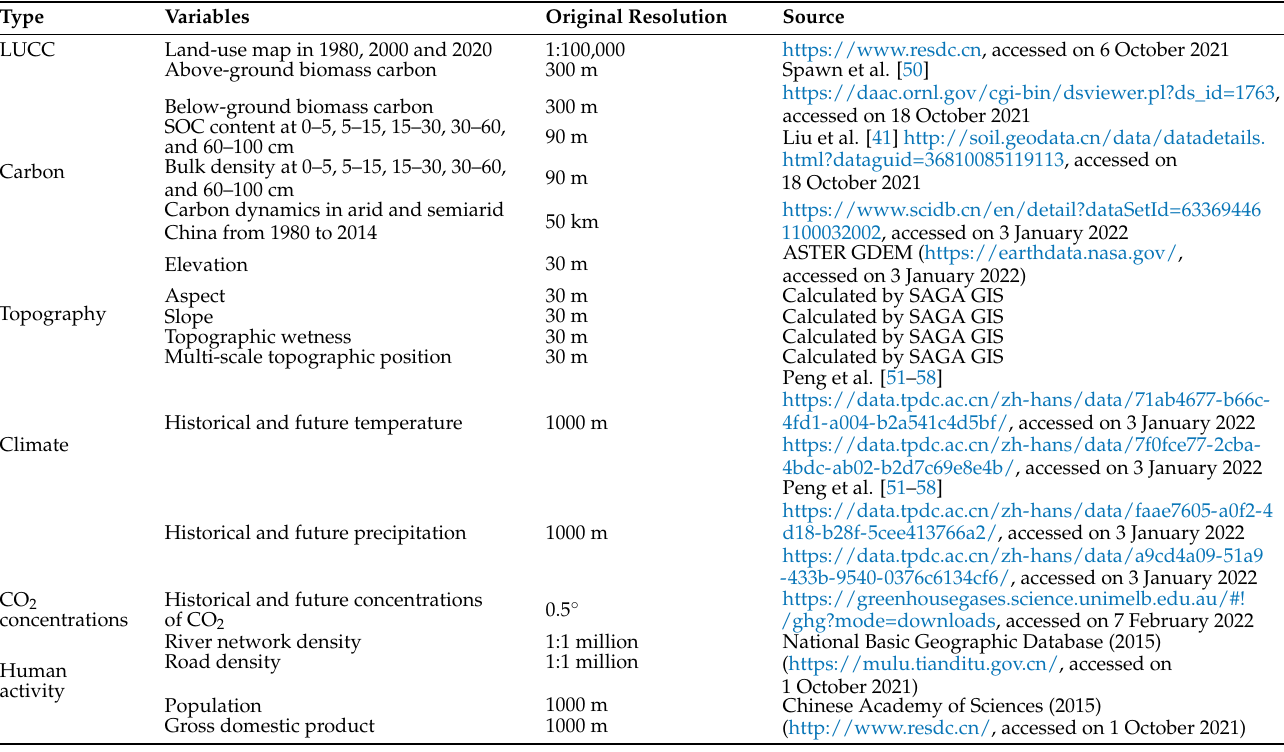
Table 1. Datasets used in this